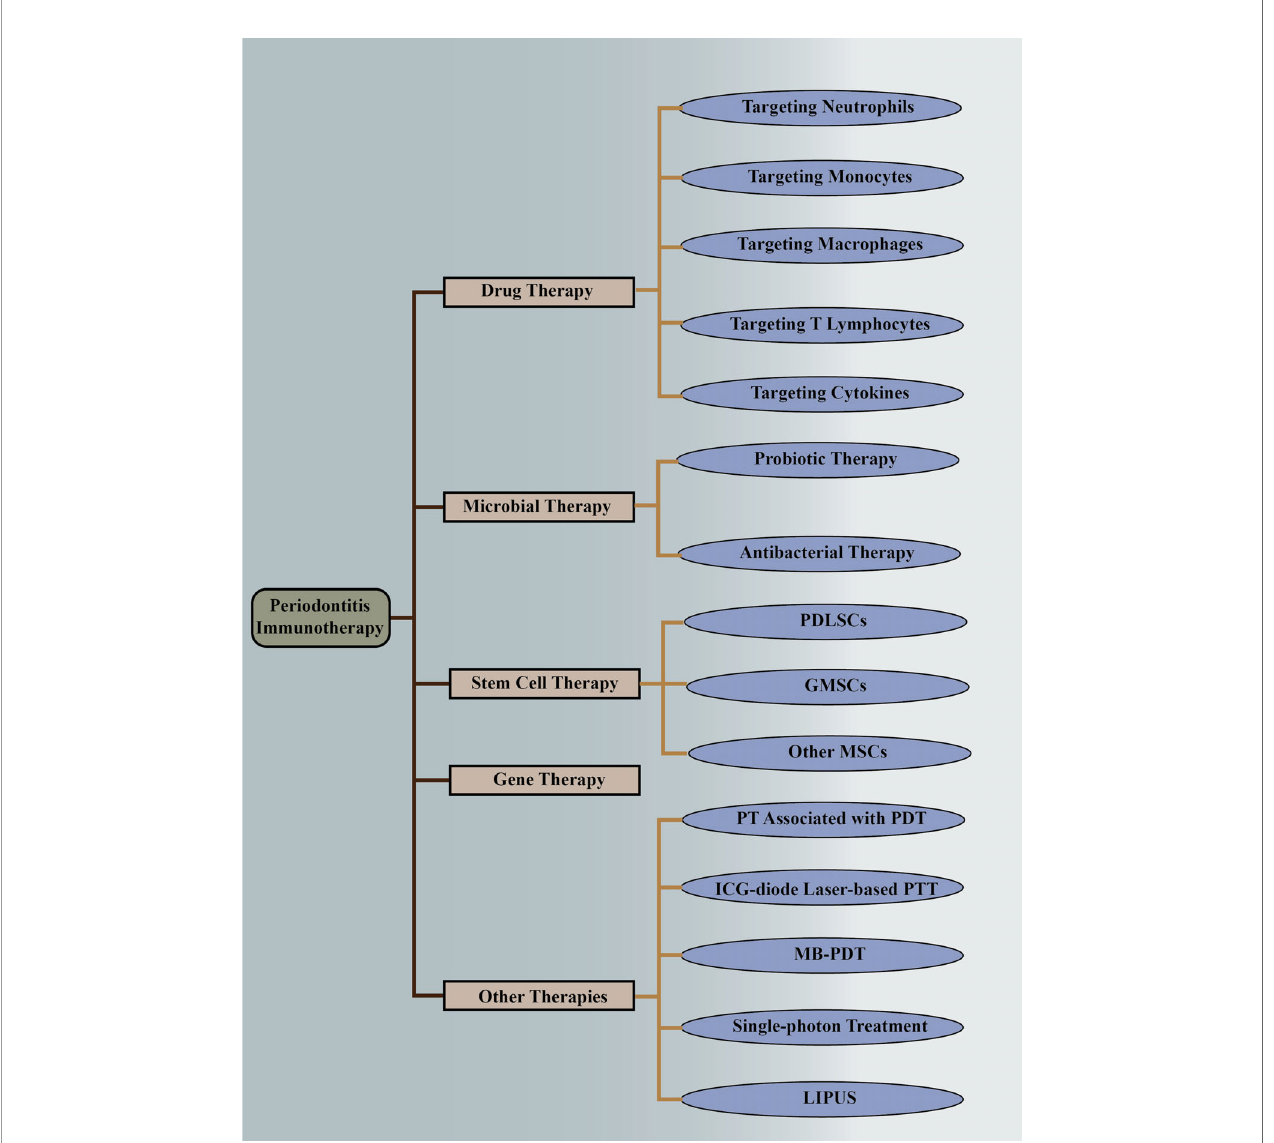
FIGURE 1 | Immunotherapies of periodontitis. The above is a detailed classi fi cation of periodontitis immunotherapy, including drug therapy, microbial therapy, stem cell therapy, gene therapy, and other therapies. They are followed by more detailed classi fi cations. PDLSCs, periodontal ligament stem cells; GMSCs, gingival mesenchymal stem cells; MSCs, mesenchymal stem cells; PT, periodontal therapy; PDT, photodynamic therapy; ICG, indocyanine green; PTT, photothermal therapy; MB-PDT, methylene blue-mediated photodynamic therapy; LIPUS, low-intensity pulsed